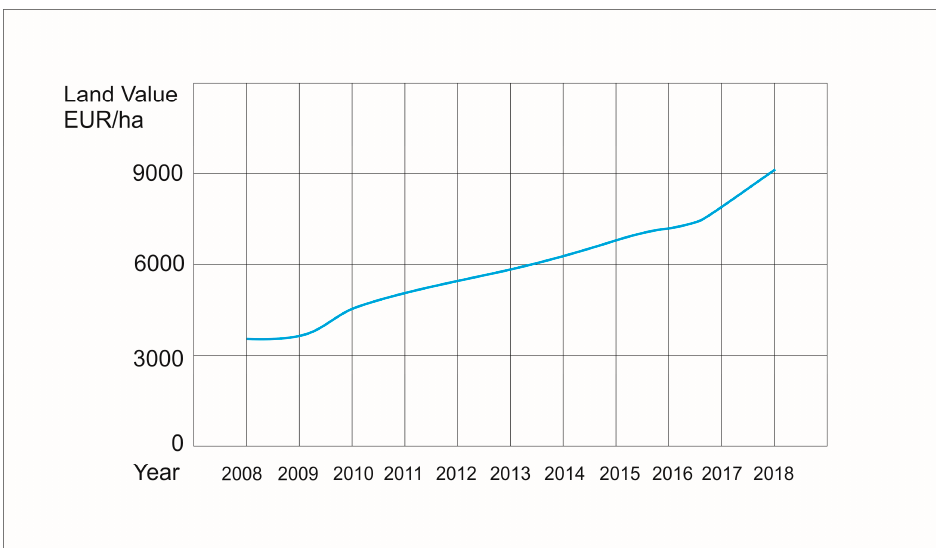
Figure 1. Agricultural land prices development.